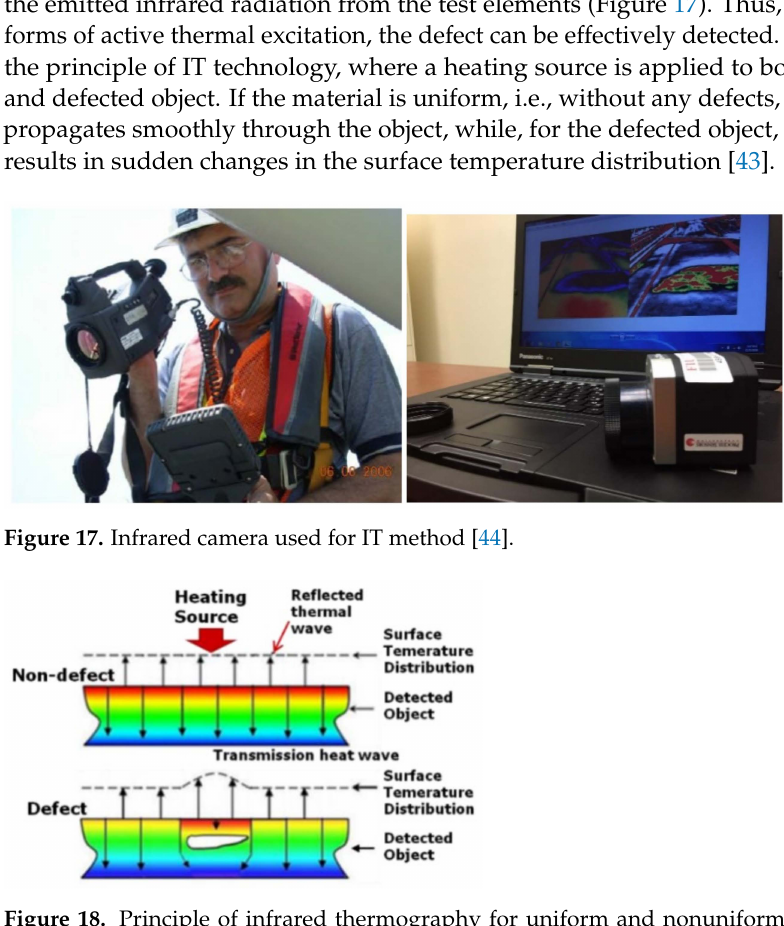
Figure 18. Principle of infrared thermography for uniform and nonuniform elements and their thermal wave propagation